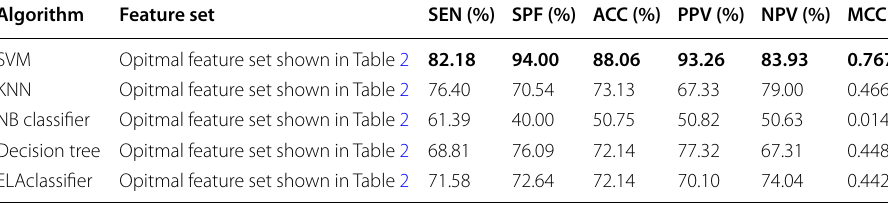
Bold values to highlight the relevant numbers Table 9 Performance indexes for the optimal subset and for each classification algorithm using 10-fold style under fast walking speed Algorithm